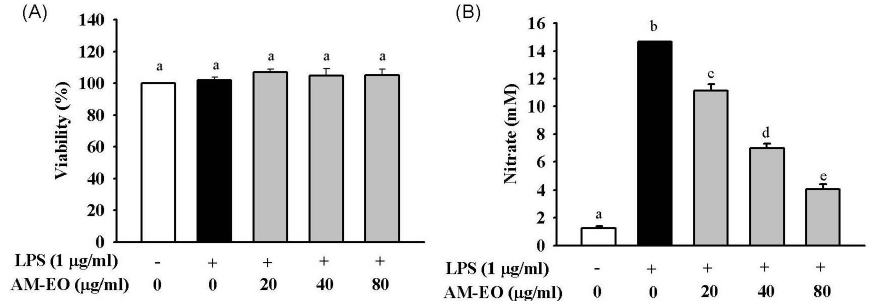
Figure 2. The effect of A. millefolium essential oil (AM-EO) on ( A ) cell viability and ( B ) nitric oxide (NO) production in lipopolysaccharides (LPS)-induced RAW 264.7 macrophages. Each value represents the mean ± SD ( n = 3). Groups sharing the same superscript letter are not significantly different ( p > 0.05) as revealed by Dunnett’s post hoc